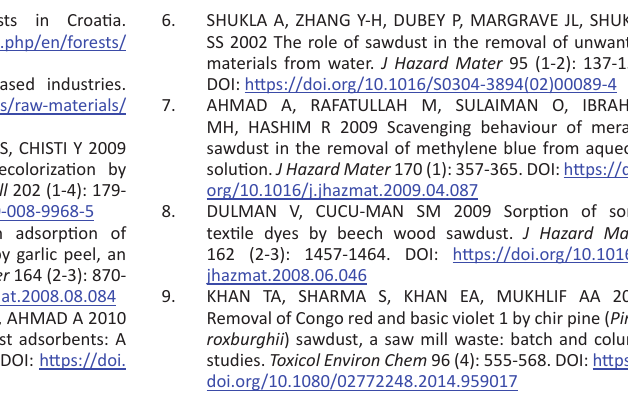
The Freundlich isotherm model assumes the non- ideal adsorption on heterogeneous surfaces and multilayer adsorption and interaction between the adsorbed molecules [37]. The linear form of the Freundlich equation is given as: